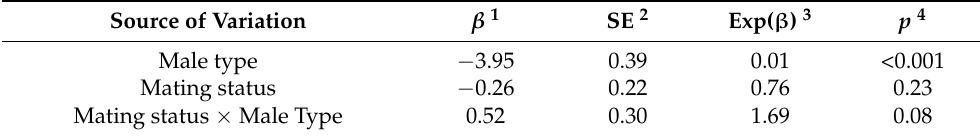
Different letters indicate significant differences (pairwise comparisons, log rank test, p < 0.05). Table 5. Variables of the Cox proportional hazards model regarding effects of male type and mating on the adult lifespan.